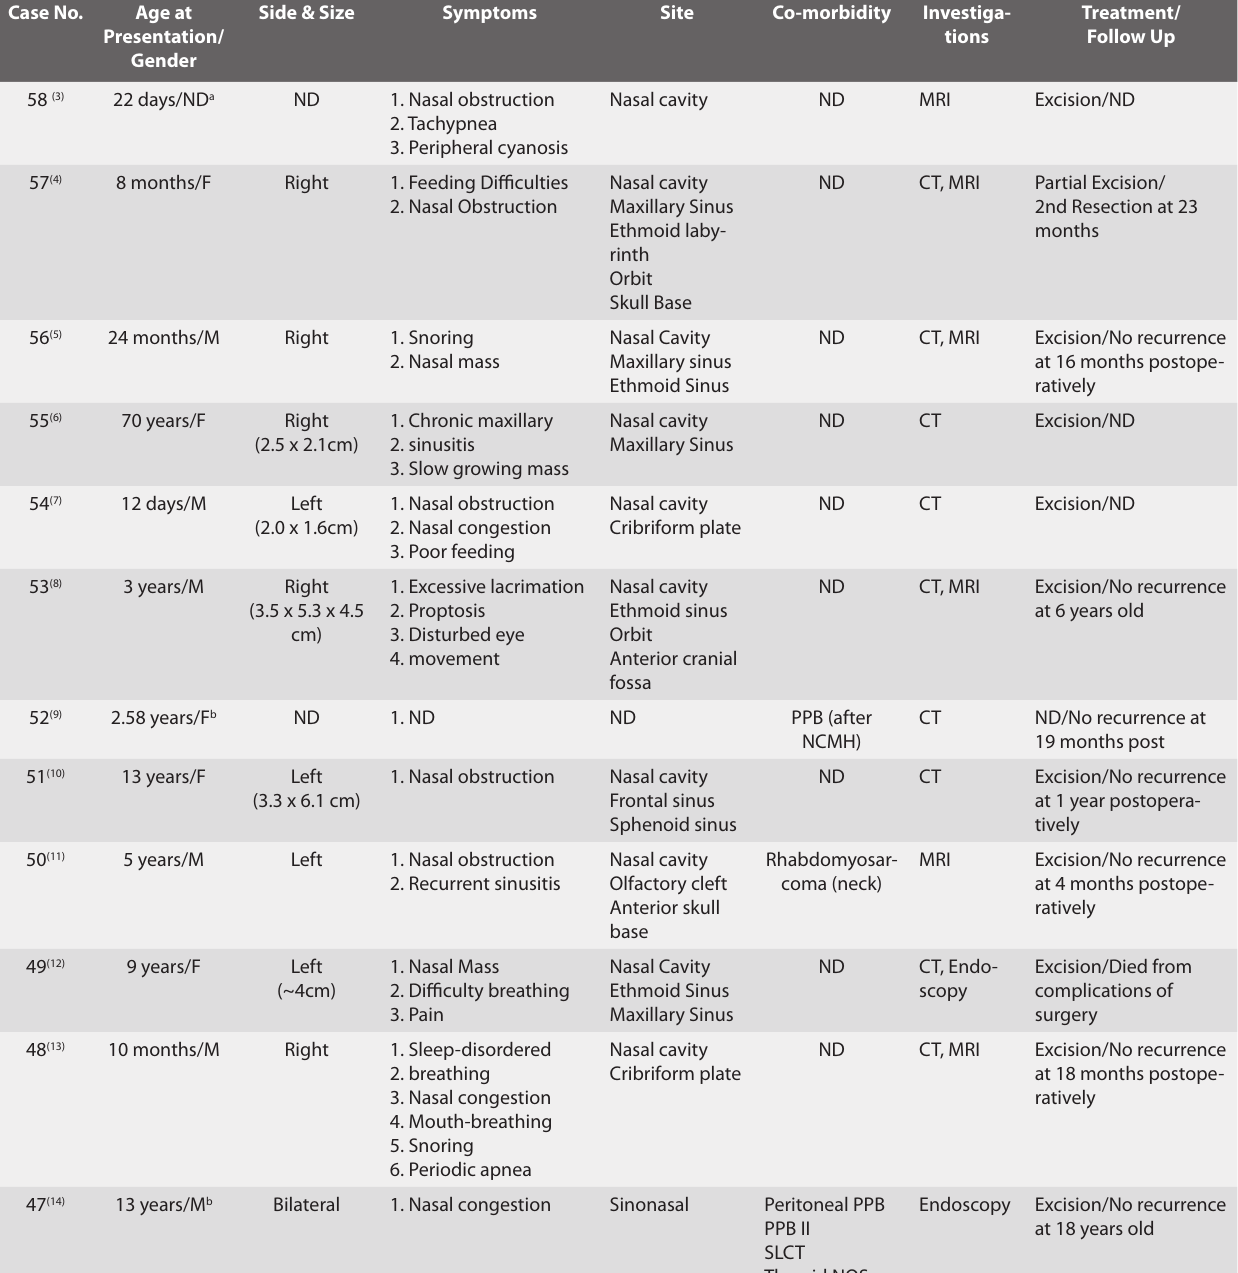
Supplementary Table 2. Review of published nasal mesenchymal hamartoma cases from 2015 through February 2019. Case